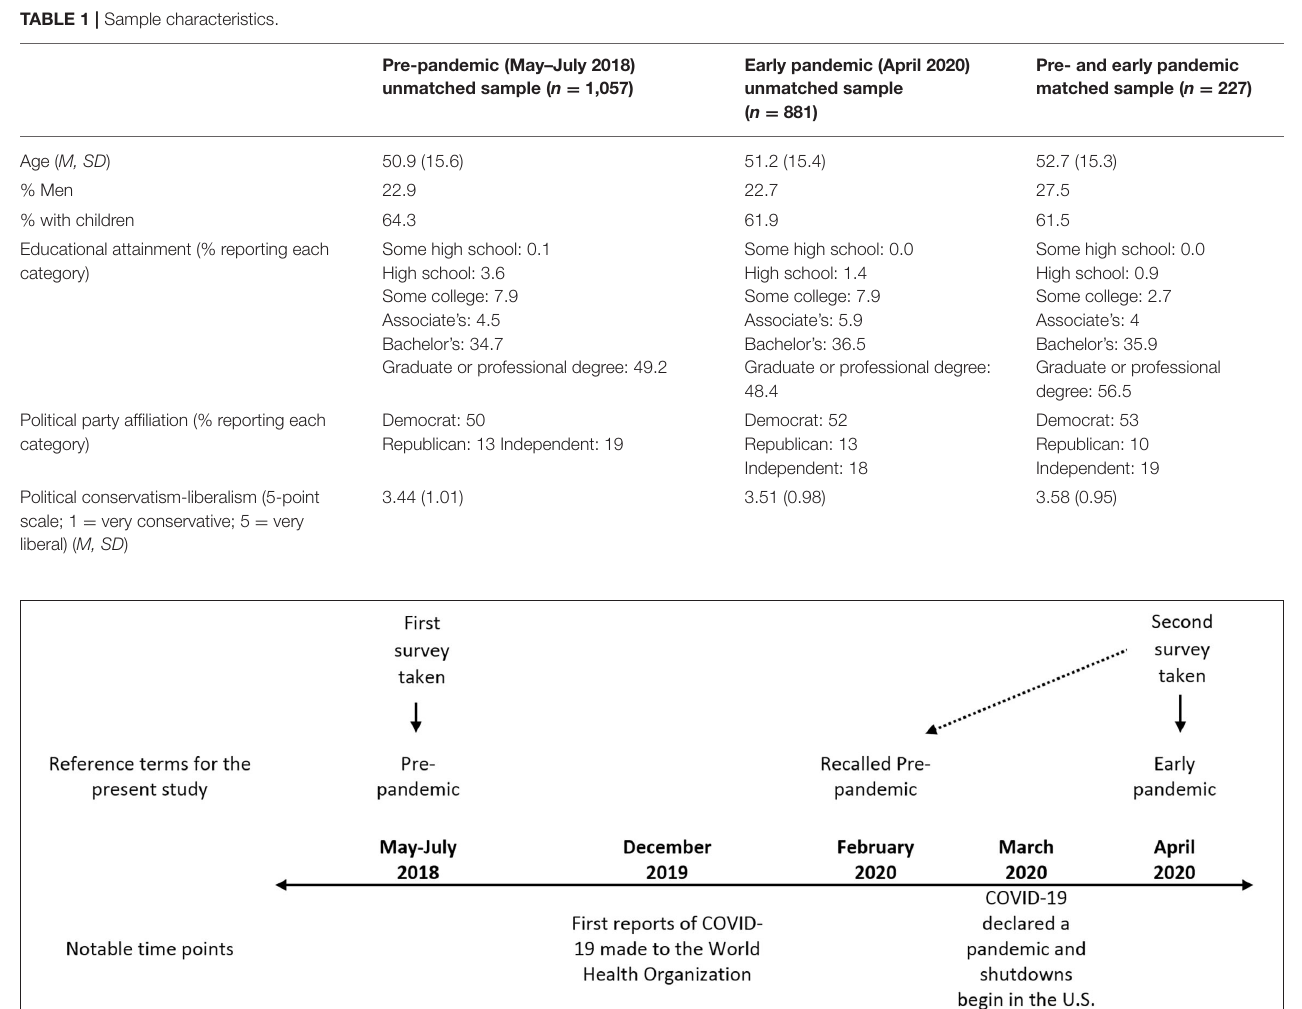
FIGURE 1 | Timeline of